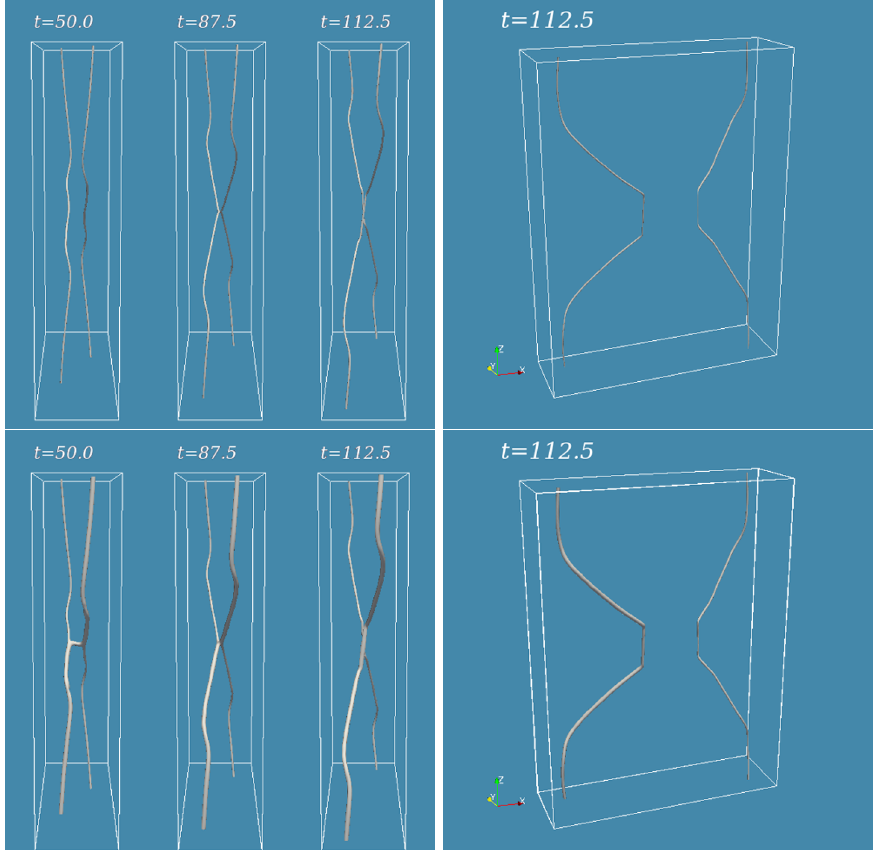
Figure 4 . Collision between a compensated string with ( n 1 ; n 2 ) = (1 ; 2) and an uncompensated string with ( n 1 ; n 2 ) = (1 ; 1) for (cid:11) = 0 : 06 (cid:25) . The notation is the same as (cid:12)gure 1. After the (cid:12)rst reconnection before t = 50 : 0 (cid:17) (cid:0) 1 , the second reconnection takes place at t = 87 : 5 (cid:17) (cid:0) 1 1